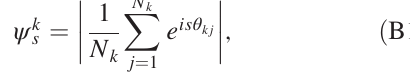
FIG. 7. A schematic diagram of an electric field cell. The sample space that is filled with colloidal suspension is shown in